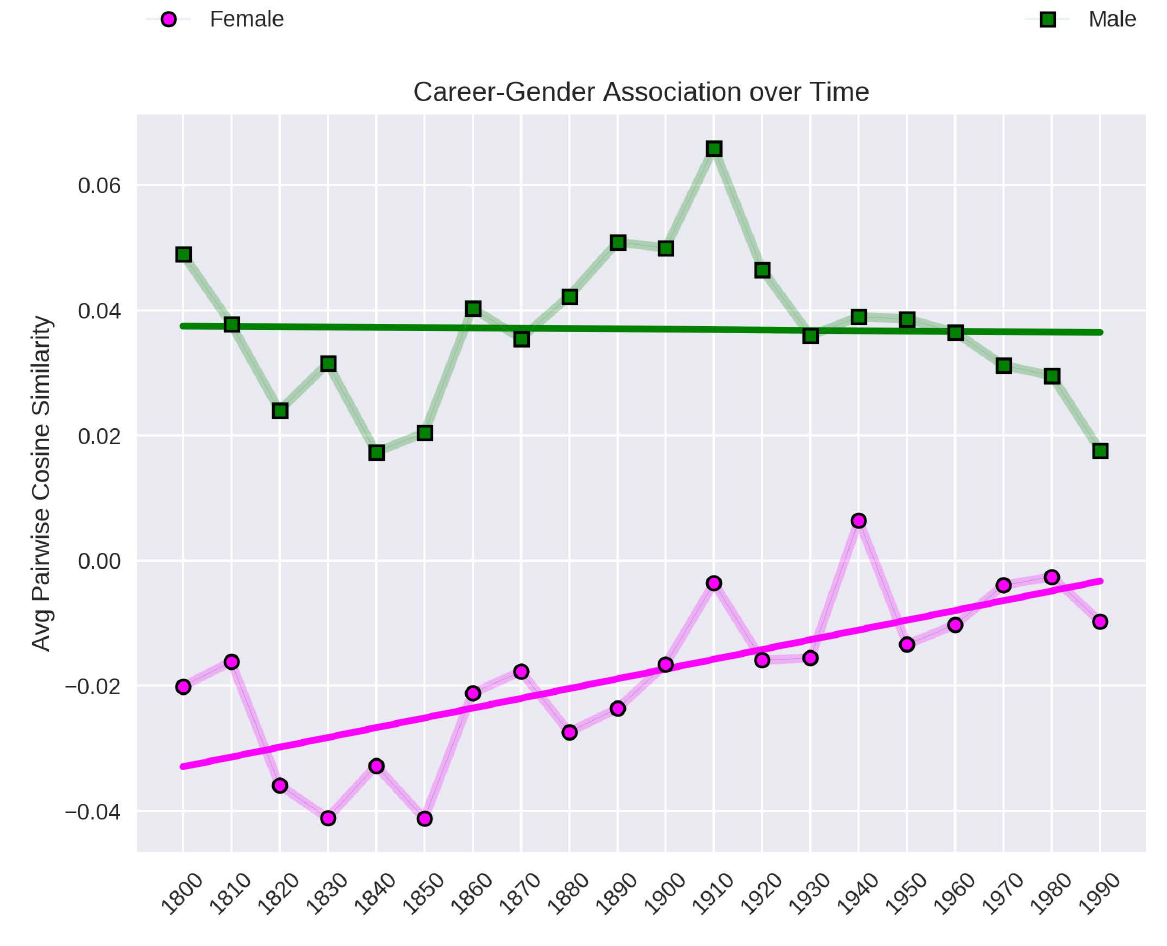
Figure 4: Female association and male association with the Career domain measured by decade. The x axis is labeled with the first year of each decade (e.g., the label “1910” is used to mark the measurement based on the word embedding trained on text from 1910 up to but not including 1920). Avg,